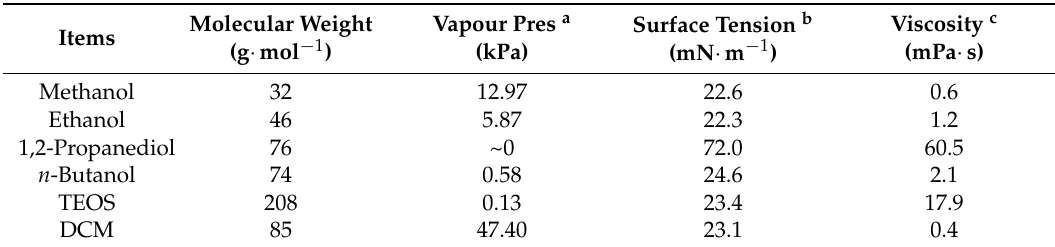
Figure 4. Schematic summary of the formation mechanism and application of diverse MPs derived with the aid of various non-solvent collecting media. Nos. 1–4 stands for solution viscosity, surface tension, vapour pressure and molecular weight of the non-solvent, respectively. NIPS, non-solvent-induced phase separation. Table 1. Physical properties of solvents used during porous microparticle production. TEOS, tetraethyl